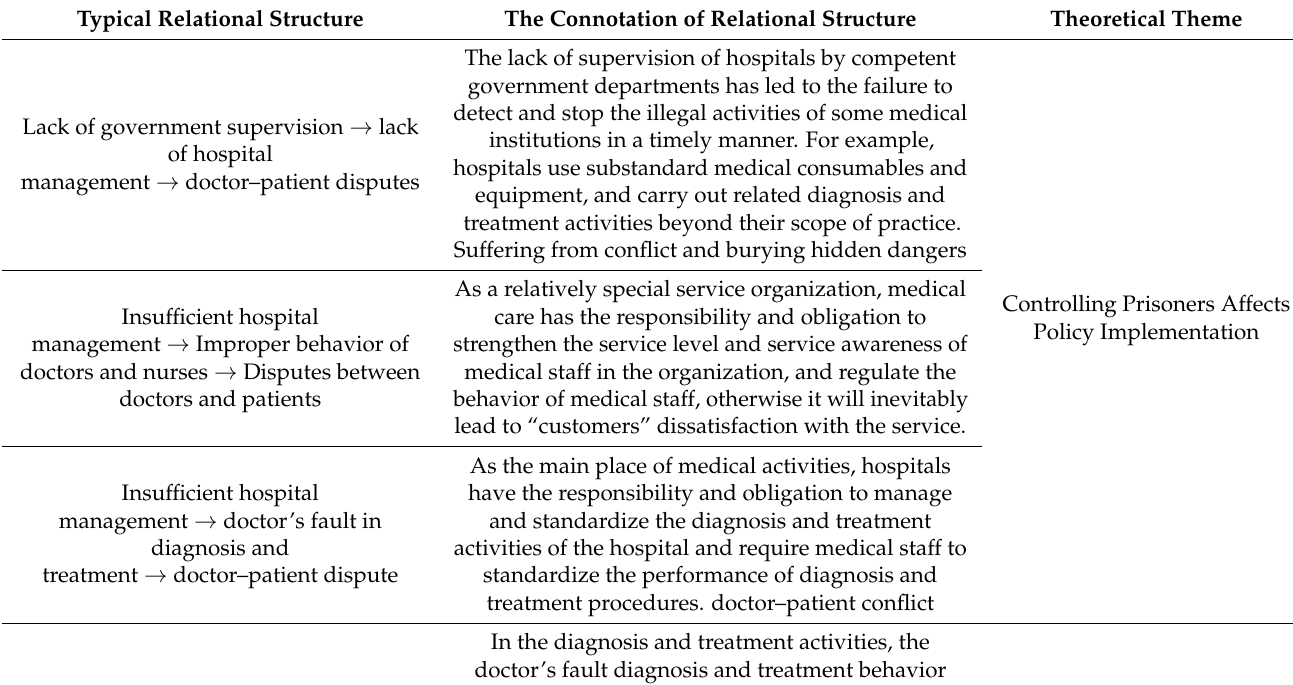
Table 4. Typical relational structure of main